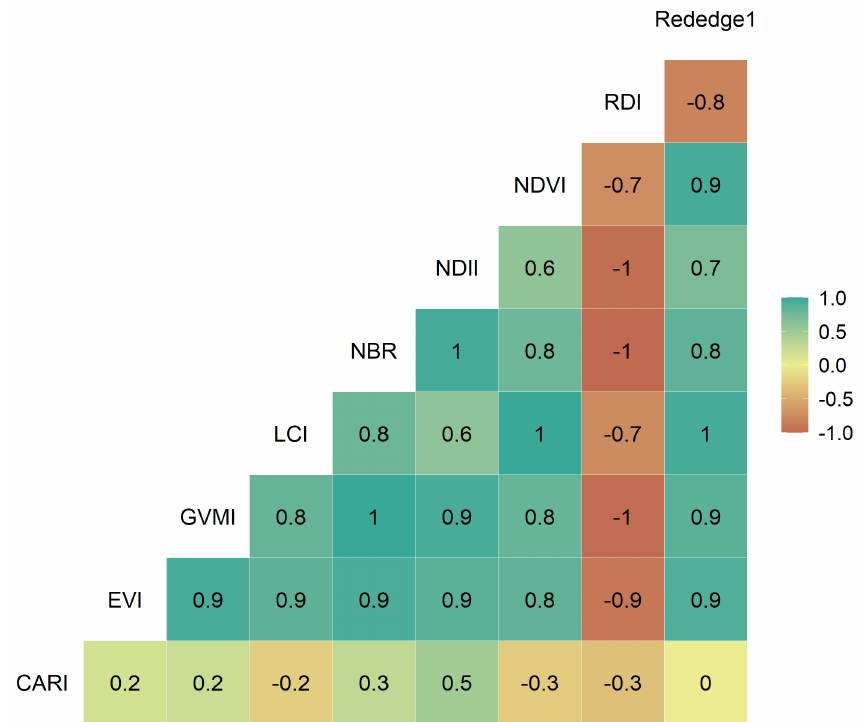
Figure 5. Correlation matrix between vegetation indices, value corresponds to Pearson’s correlation coefficient